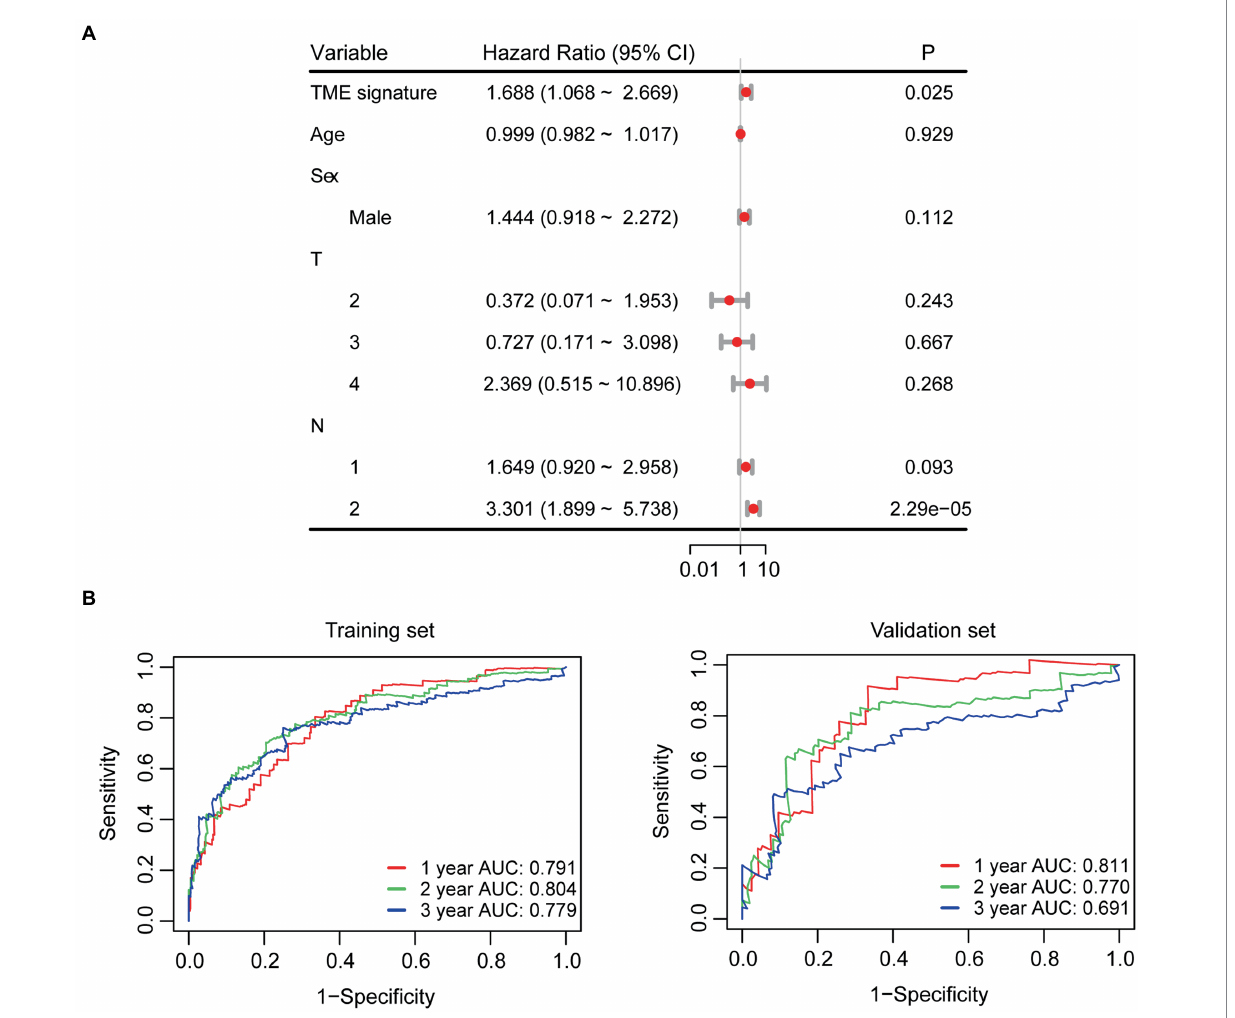
FIGURE 3 Survival analyses. (A) Multivariate Cox regression analyses for TME signature and clinical variables. (B) Time-dependent ROC curves of the combined model.